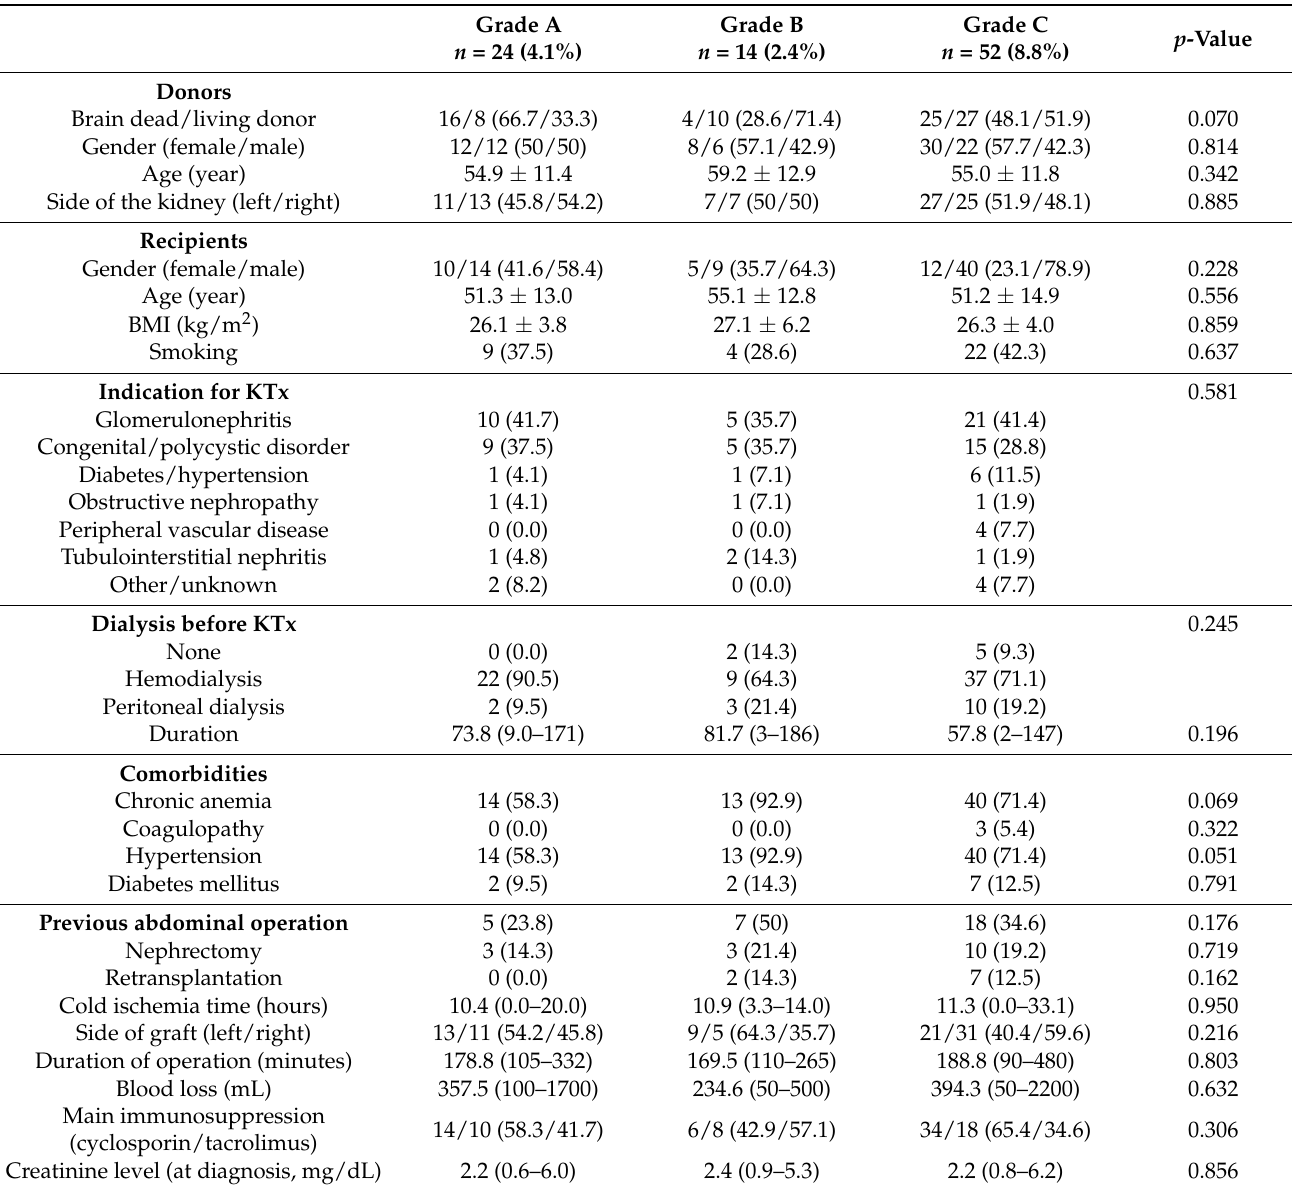
Table 2. Donors’ and recipients’ perioperative data categorized based on the grade of lymphocele formation following kidney transplantation with comparison between the